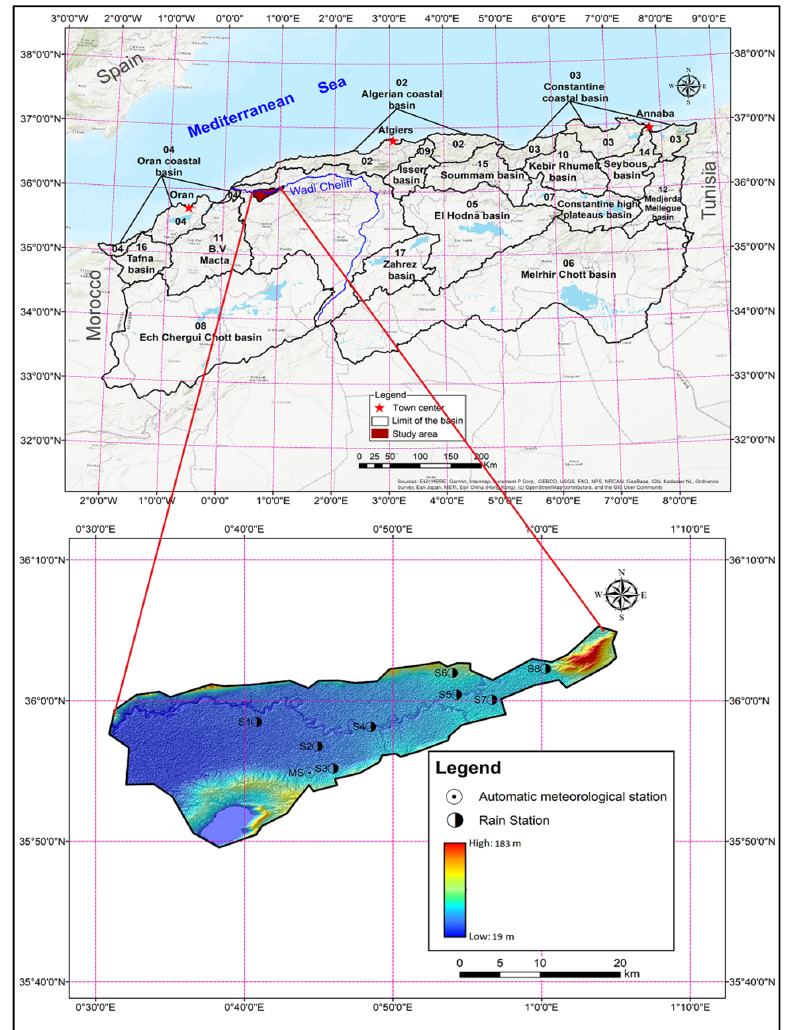
Figure 1. Lower Cheliff Plain situation.